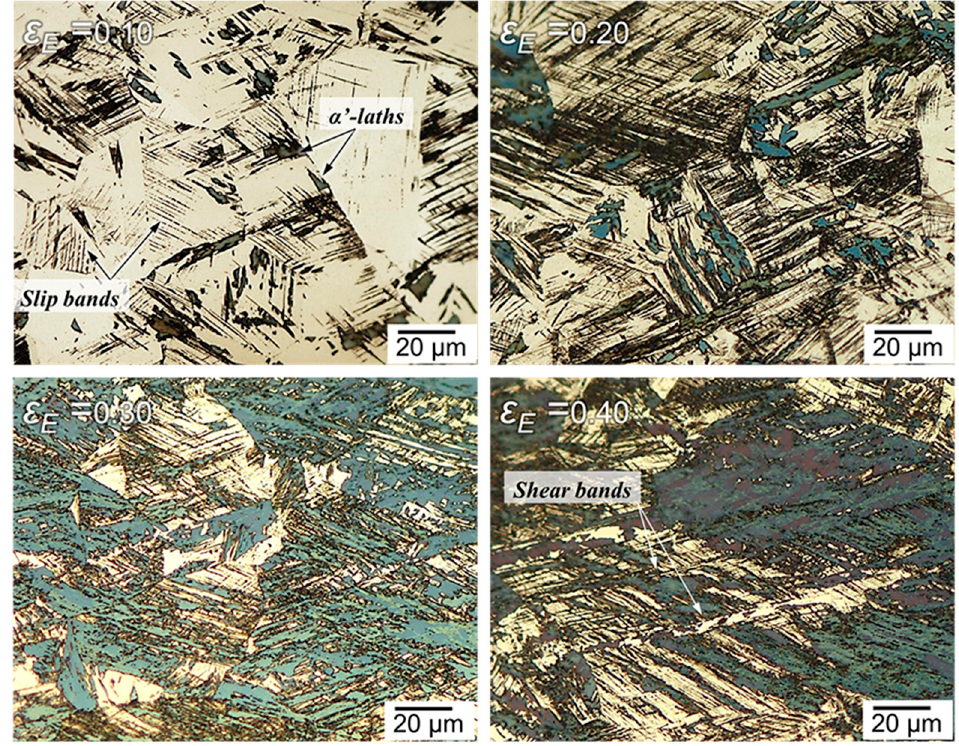
Figure 3. Light-optical micrographs of tensile-tested specimens interrupted at strains ( ε E ) of 0.10, 0.20, 0.30, and 0.40 after etching with Beraha’s reagent for 10 s. The martensite phase is revealed in black and blue, whereas the austenite phase remains unetched.